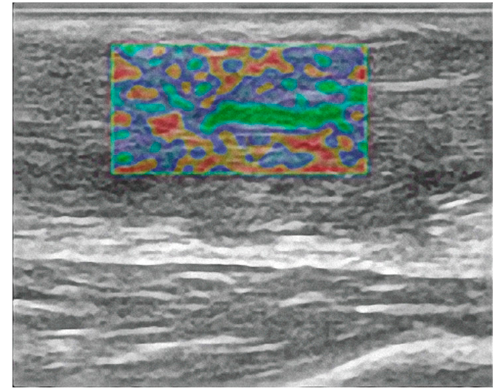
Figure 3. Longitudinal elastography image of Achilles tendon after surgery.